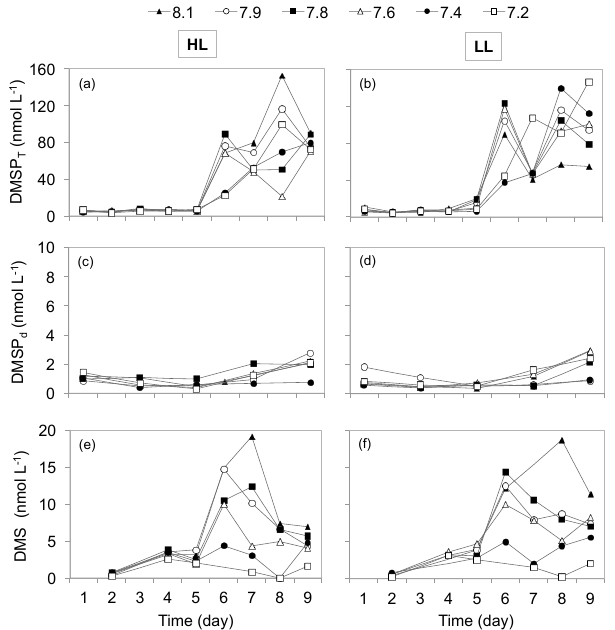
Figure 7. Temporal variations in (a, b) total DMSP (DMSP T ) , (c, d) dissolved DMSP (DMSP d ) , and (e, f) DMS concentrations during the microcosm experiment. Left and right panels show vari- ations under the high light (HL) and low light (LL) treatments, respectively. Each curve represents a microcosm identified by its mean pH T value.